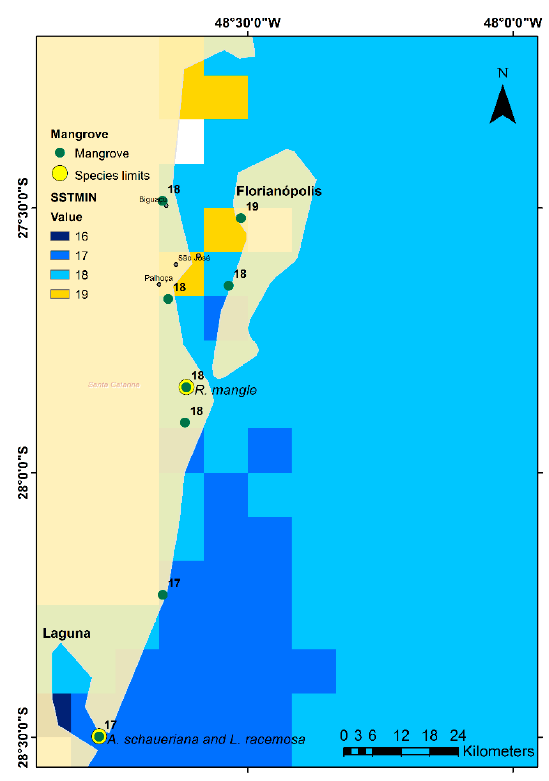
Figure 10. SSTMIN variation at the southernmost limit. Map showing the distribution and variation of SSTMIN at the mangrove limits in the state of Santa Catarina. Note that within Laguna, the SSTMIN variation ranges over 16 °C, 17 °C and 18 °C, averaging to 17 °C ± 1 °C. The yellow circle corresponds to the southernmost mangrove limits in Brazil.